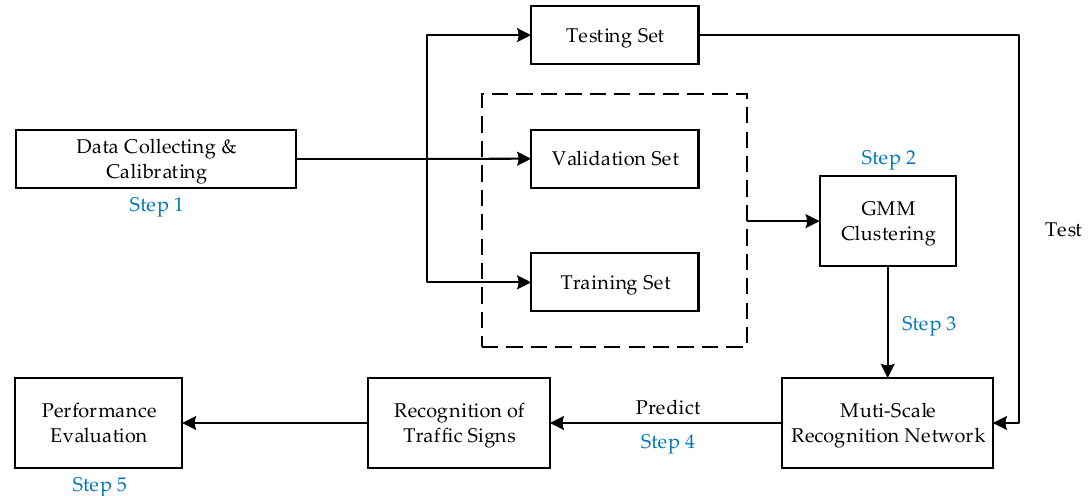
Figure 1. Traffic sign recognition algorithm. Figure 1. Tra ffi c sign recognition